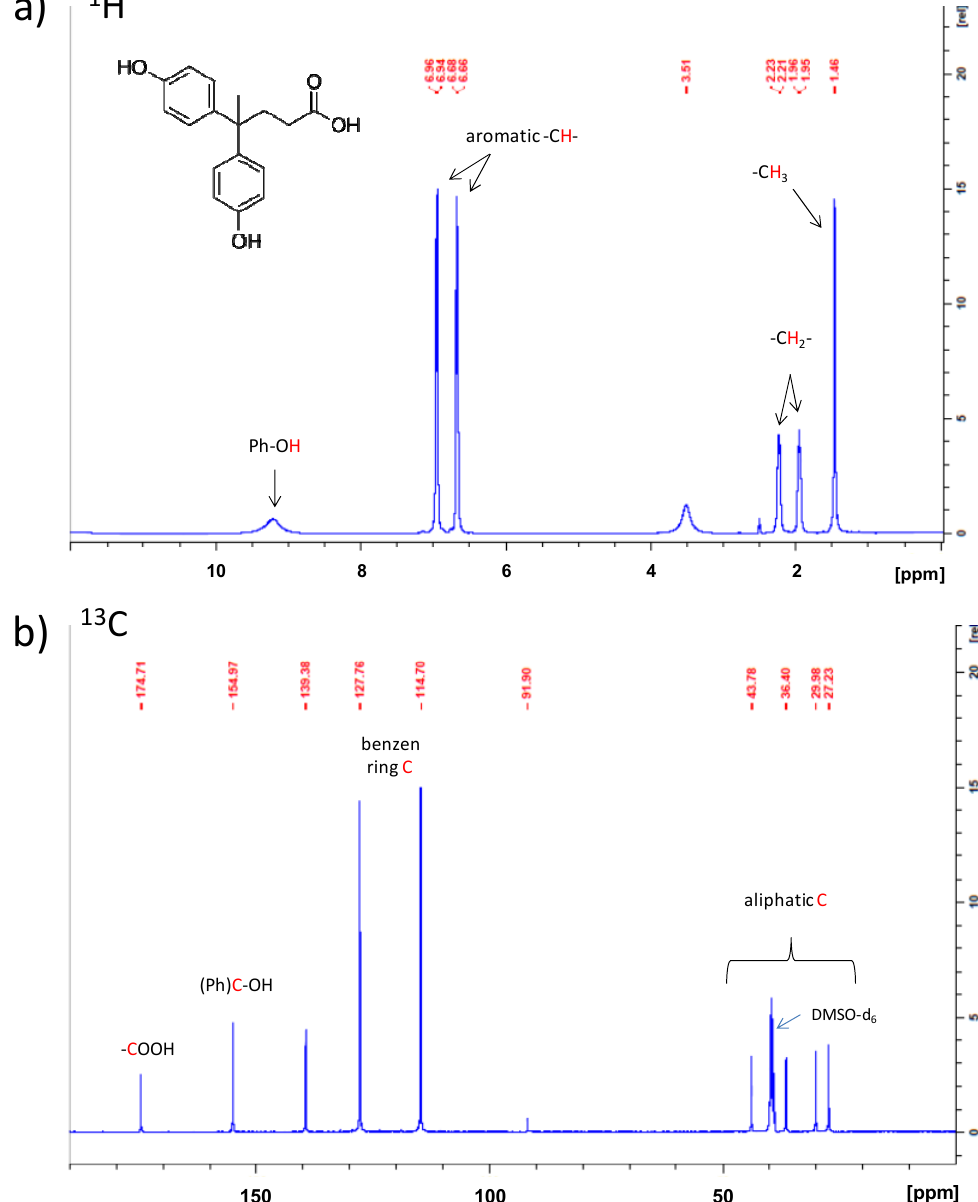
Figure 5. ( a ) 1 H and ( b ) 13 C nuclear magnetic resonance (NMR) spectra of diphenolic acid.